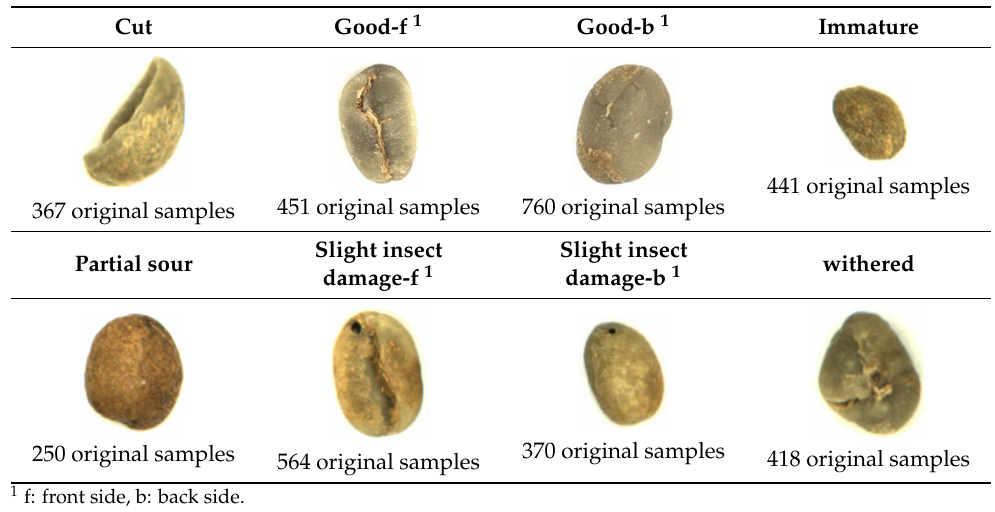
Table 3. Examples of coffee bean